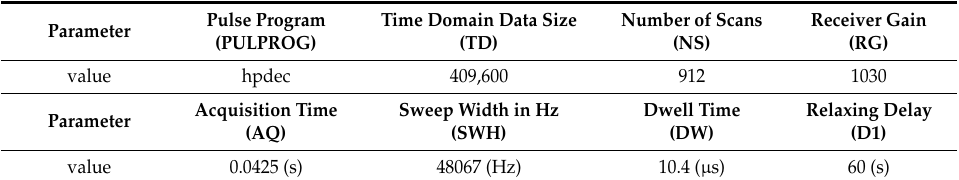
Table 3. MAS NMR operating